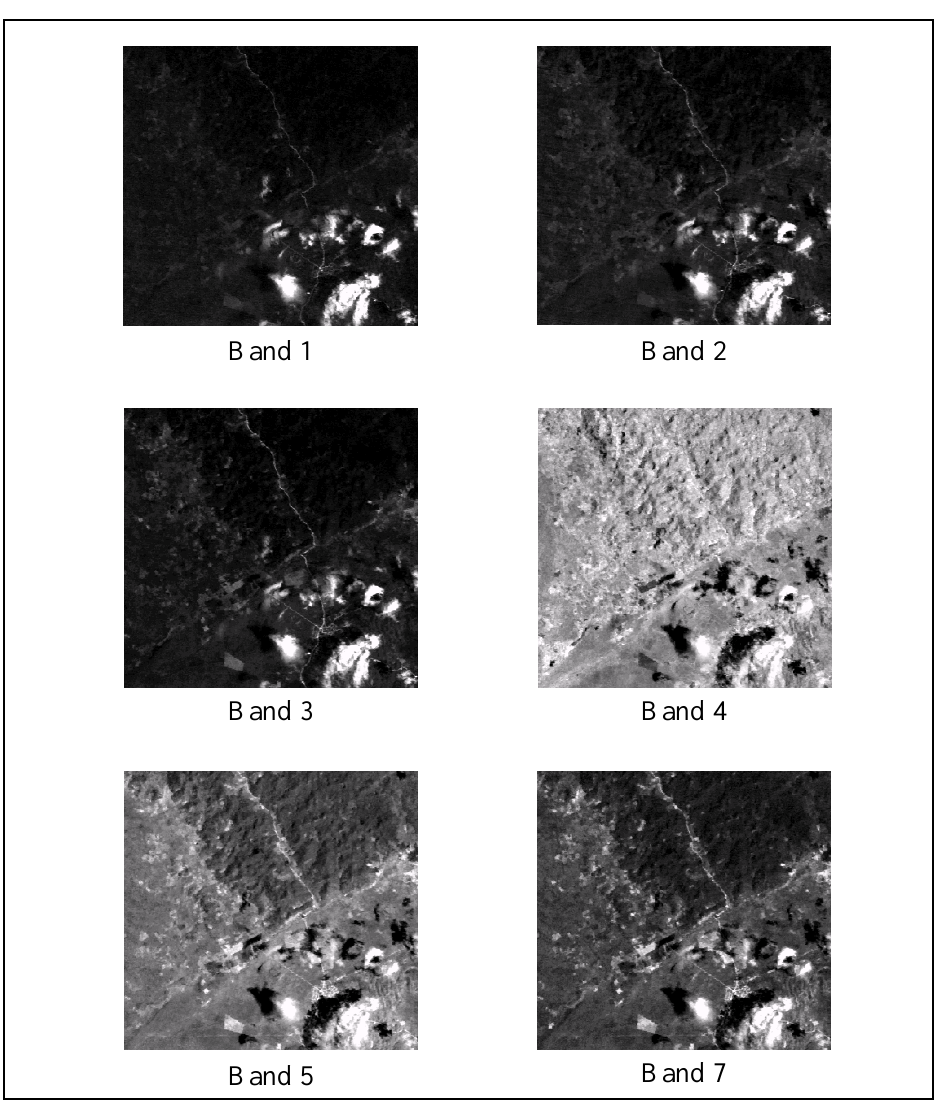
Figure 4. Multiple spectral images of Landsat TM data for Guatemala study